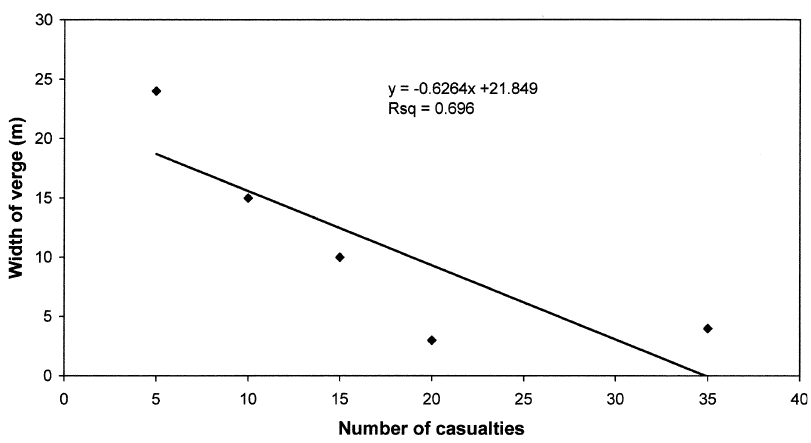
Fig. 2. Graph showing the rela- tionship between verge width (m) and the totalled number of casualties for the whole survey, standardised for unit